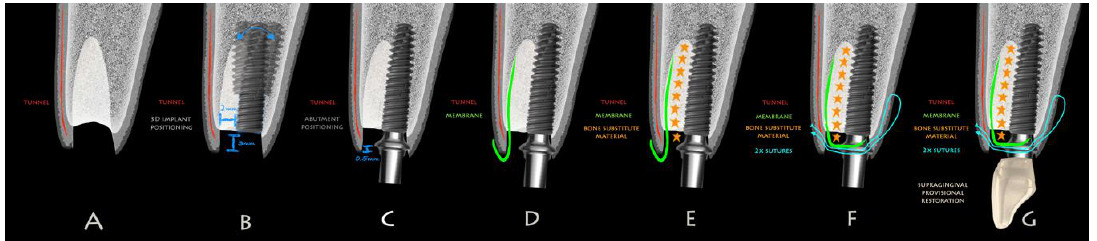
Figure 4. Atraumatic extraction of affected tooth with the use of periotomes and generation of partial thickness pouch flap with a micro-blade.